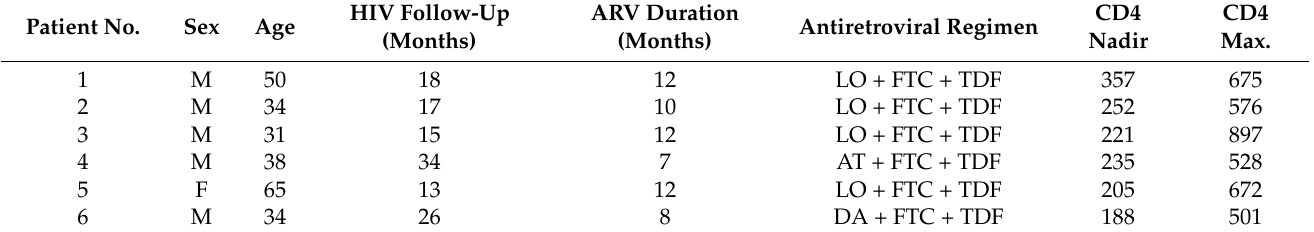
Table 1. Main characteristics of the 6 included patients. Nadir CD4 T-cells were observed before antiretroviral combinations, while CD4 max. indicates maximal CD4 T-cells value obtained during raltegravir inclusion. HIV follow-up indicates the duration of medical care since the diagnosis of HIV infection. ARV = antiretroviral combinations. LO = lopinavir, AT = atazanavir, DA = darunavir, FTC = emtricitabine, TDF =